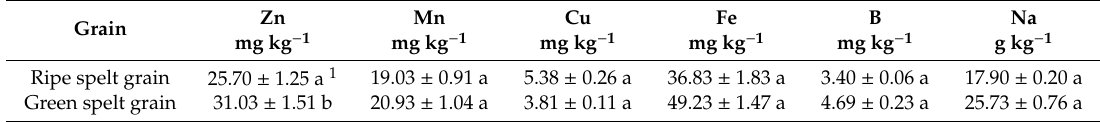
Table 2. The content of selected microelements in the grain of spelt.